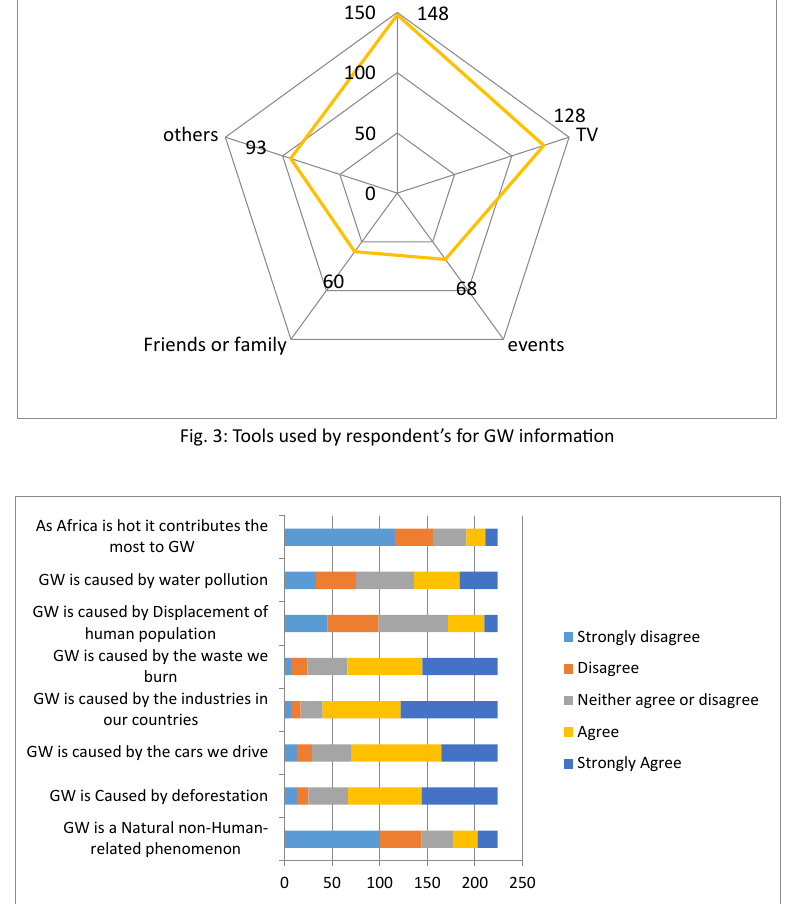
Fig. 4: Opinions on Global Warming causes